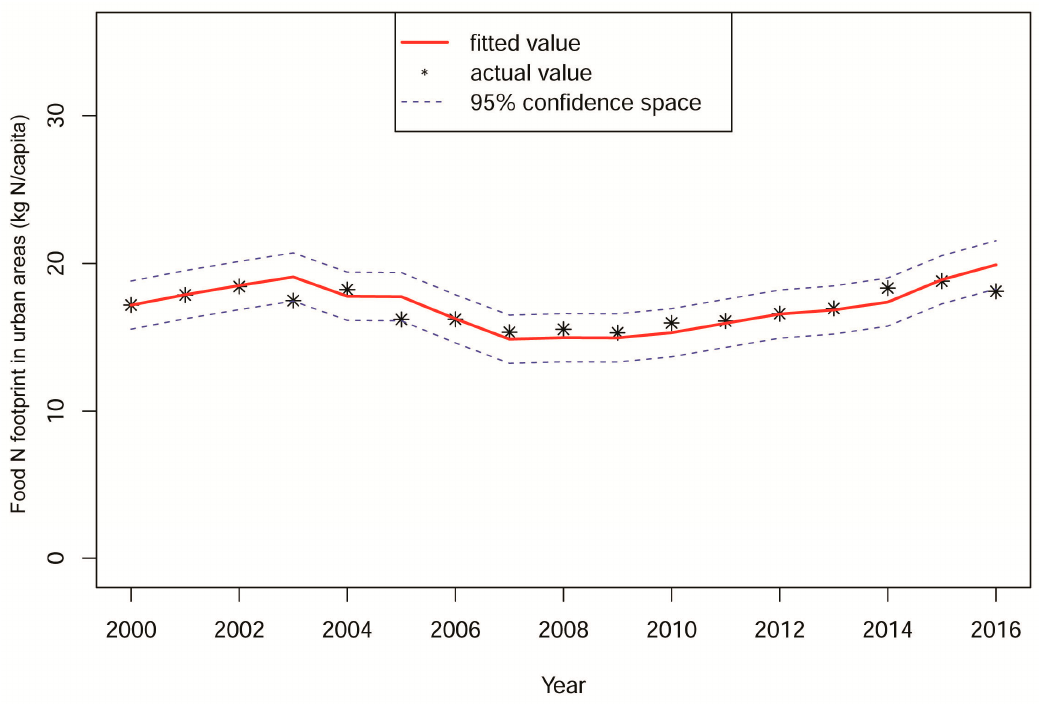
Figure 2. Predicted values fit the graph of the auto regressive integrated moving average (ARIMA) (2, 2, 0) model.